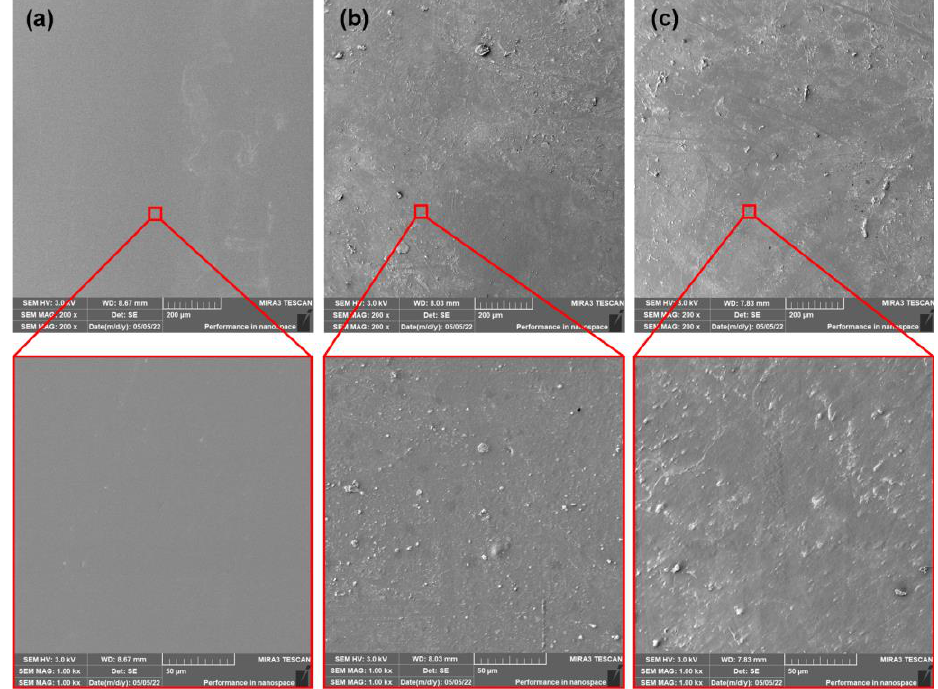
Figure 7. SEM images of aged neat PLA films ( a ) at initial state and after ( b ) 14 days of thermophilic composting, and ( c ) 28 days of thermophilic composting.